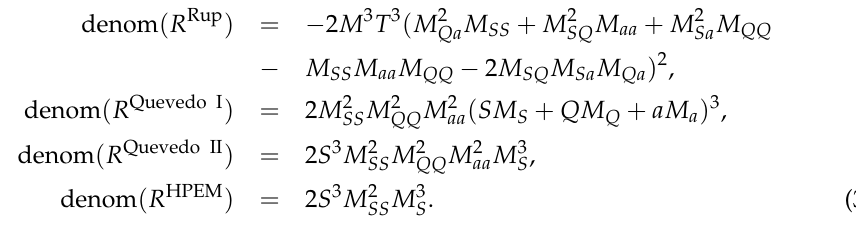
H ii L Rotatingblack holewith D= 0.5, a = 0.015